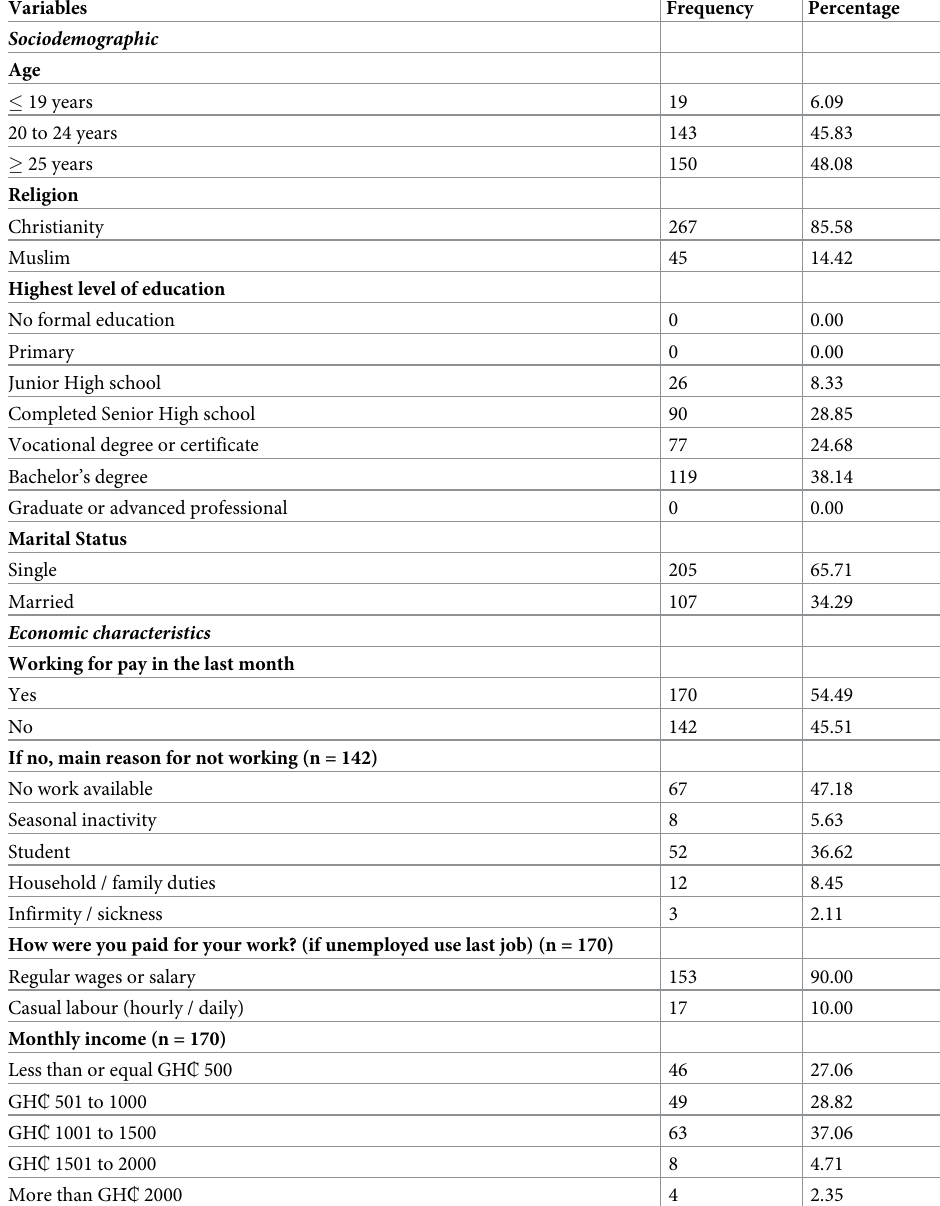
Table 1. Sociodemographic and economic characteristics of